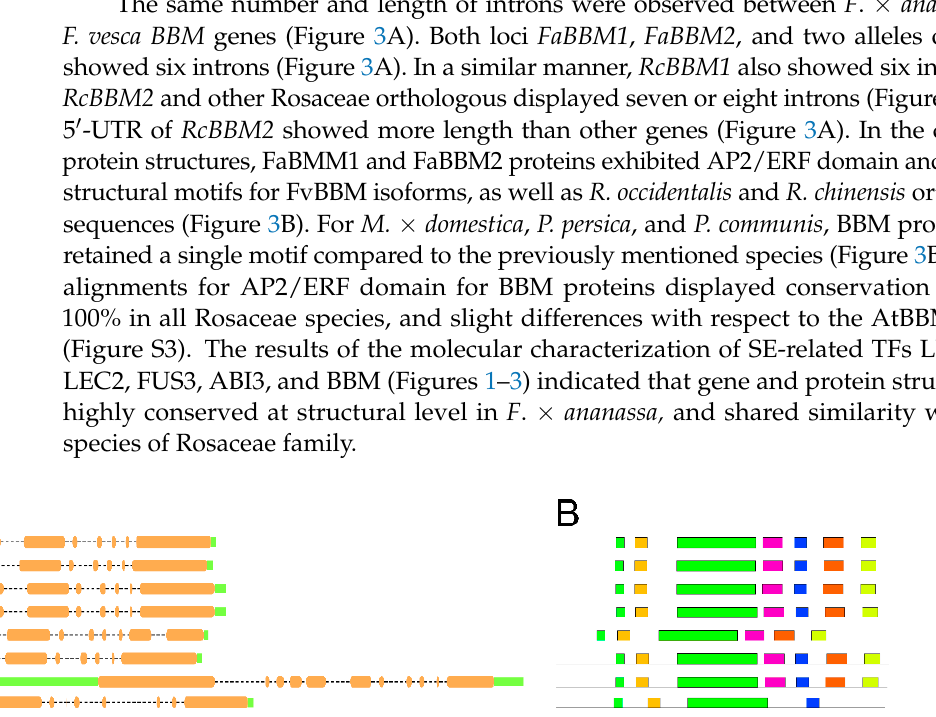
8 of 21 Figure 2. LEC2, FUS3, and ABI3 gene and protein structures in Rosaceae species and Arabidopsis